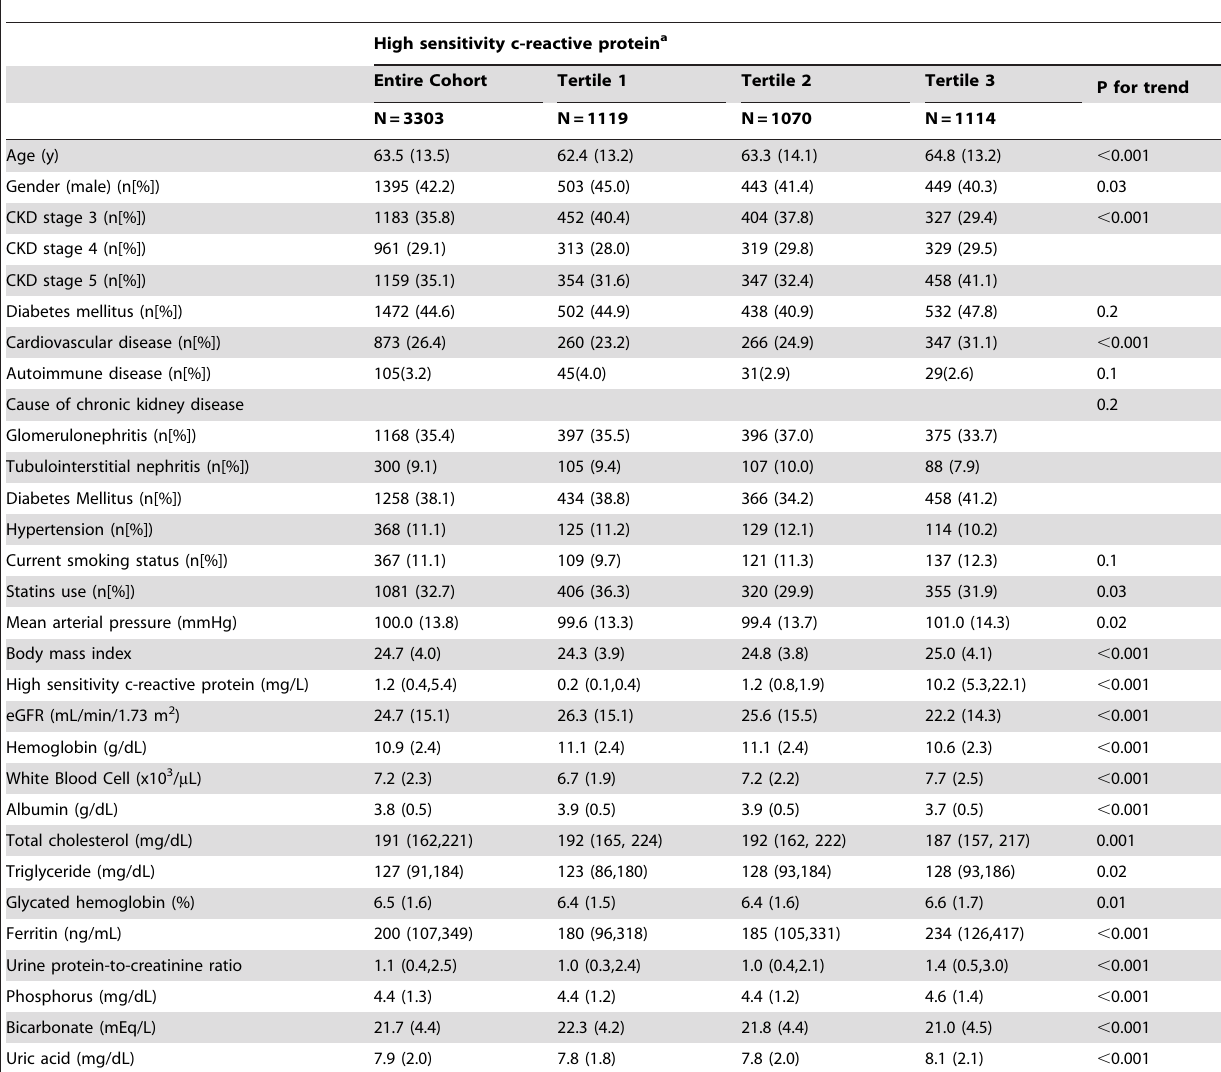
Table 1. The demographics and clinical characteristics of study